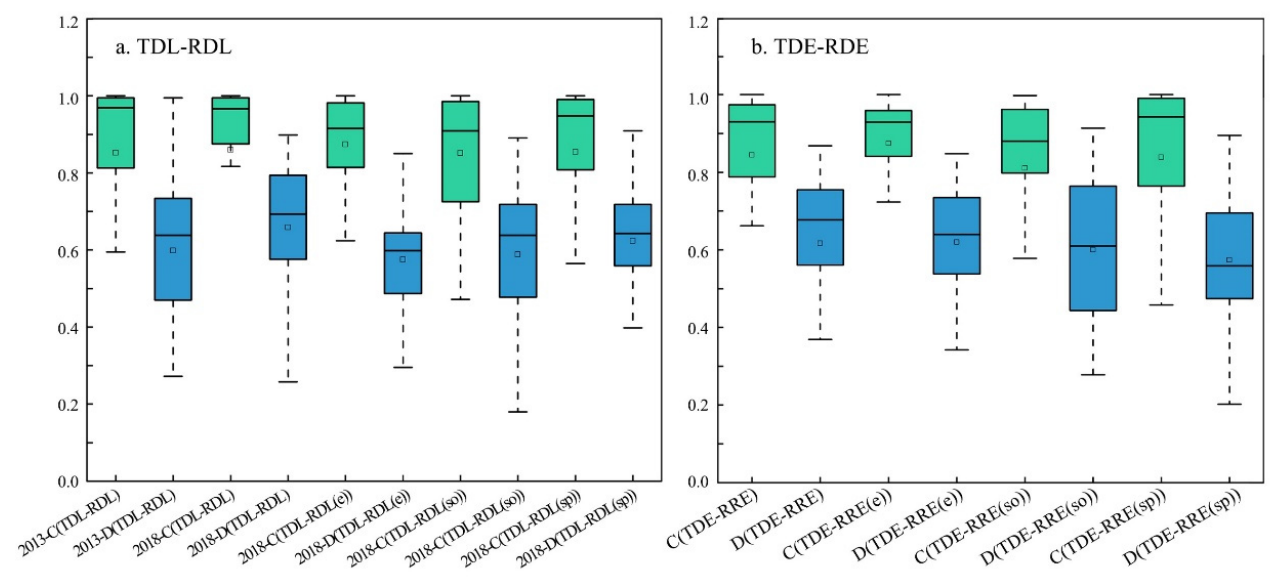
Figure 7. The results of coupling coordination degrees of TDL-RDL and TDE-RDE.